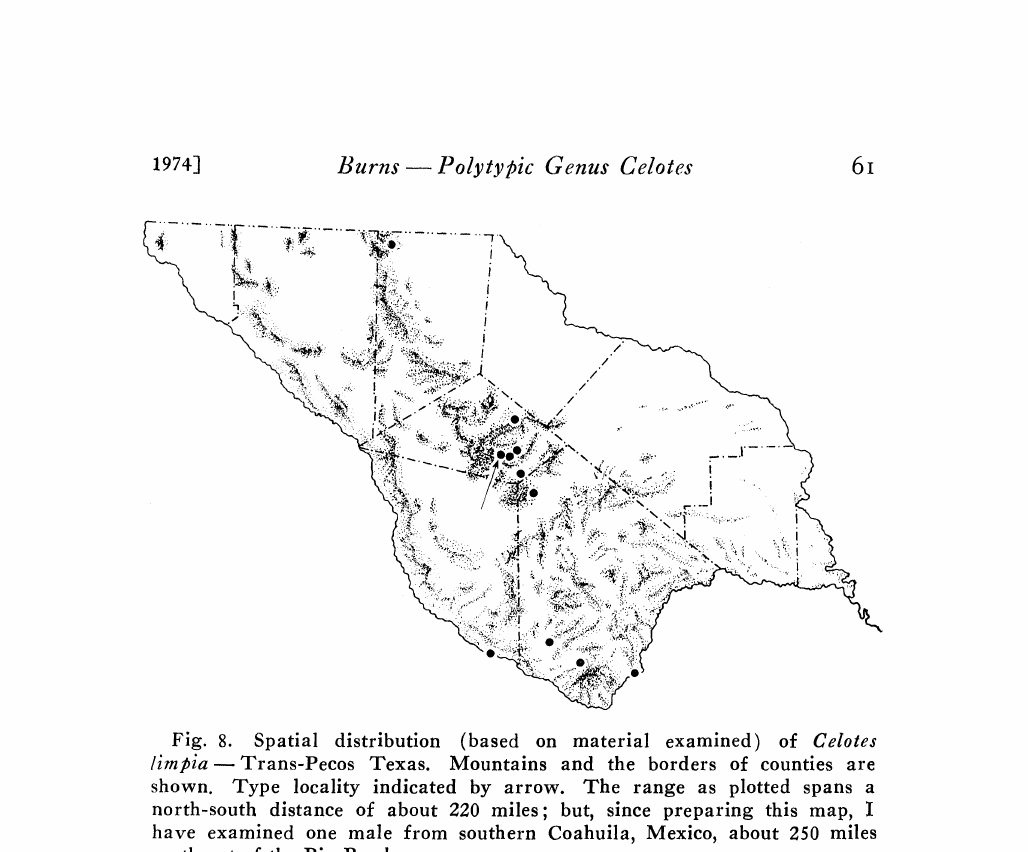
Fig. 8. Spatial distribution (based on material examined) of Celotes limpia--Trans-Pecos Texas. Mountains and the borders of counties are shown. Type locality indicated by arrow. The range as plotted spans a north-south distance of about 220 miles; but, since preparing this map, have examined one male from southern Coahuila, Mexico, about 250 miles southeast of the Big